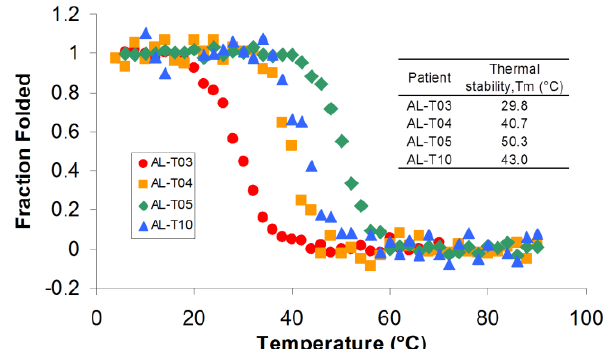
Figure 3. AL proteins present significant differences in thermal stability. The experiments were performed in 10 mM Tris–HCl, pH 7.4. The ellipticity at 217 nm was followed as a function of temperature with a scan rate of 30 °C per